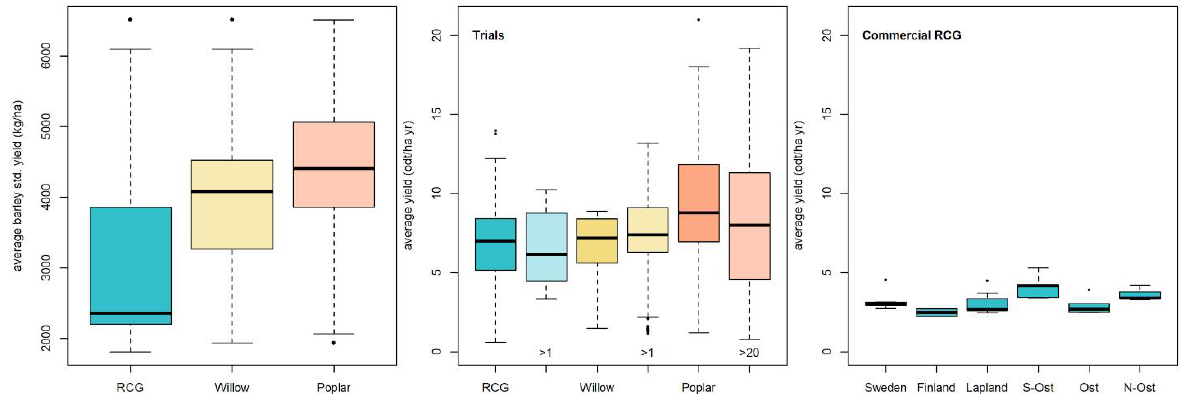
Figure 5. Land productivity yields of the trials for reed canary grass (RCG), willow, and poplar in Sweden. Left : Averaged agricultural productivity of all established plantations using the standard yields of barley by agricultural district. Centre : Average yield (oven dry tonnes, odt) from trials in Sweden for reed canary grass (1991–2010), willow (1986–2004), and poplar (1980–2015), where >1 refers to second harvest and subsequent and >20 refers to plantations over 20 years. Right : Average yield for RCG (odt) from commercial plantations for the period 2011–2017 in Sweden and Finland (counties: Lapland, South Ostrobothnia, Ostrobothnia, and North-Ostrobothnia). Finally, changes in land use show that RCG is mainly replacing meadow and cereal land, in that order, starting in 2005. However, after 2009, RCG plantations were replaced by cereals to a larger extent than meadows (Figure 6).